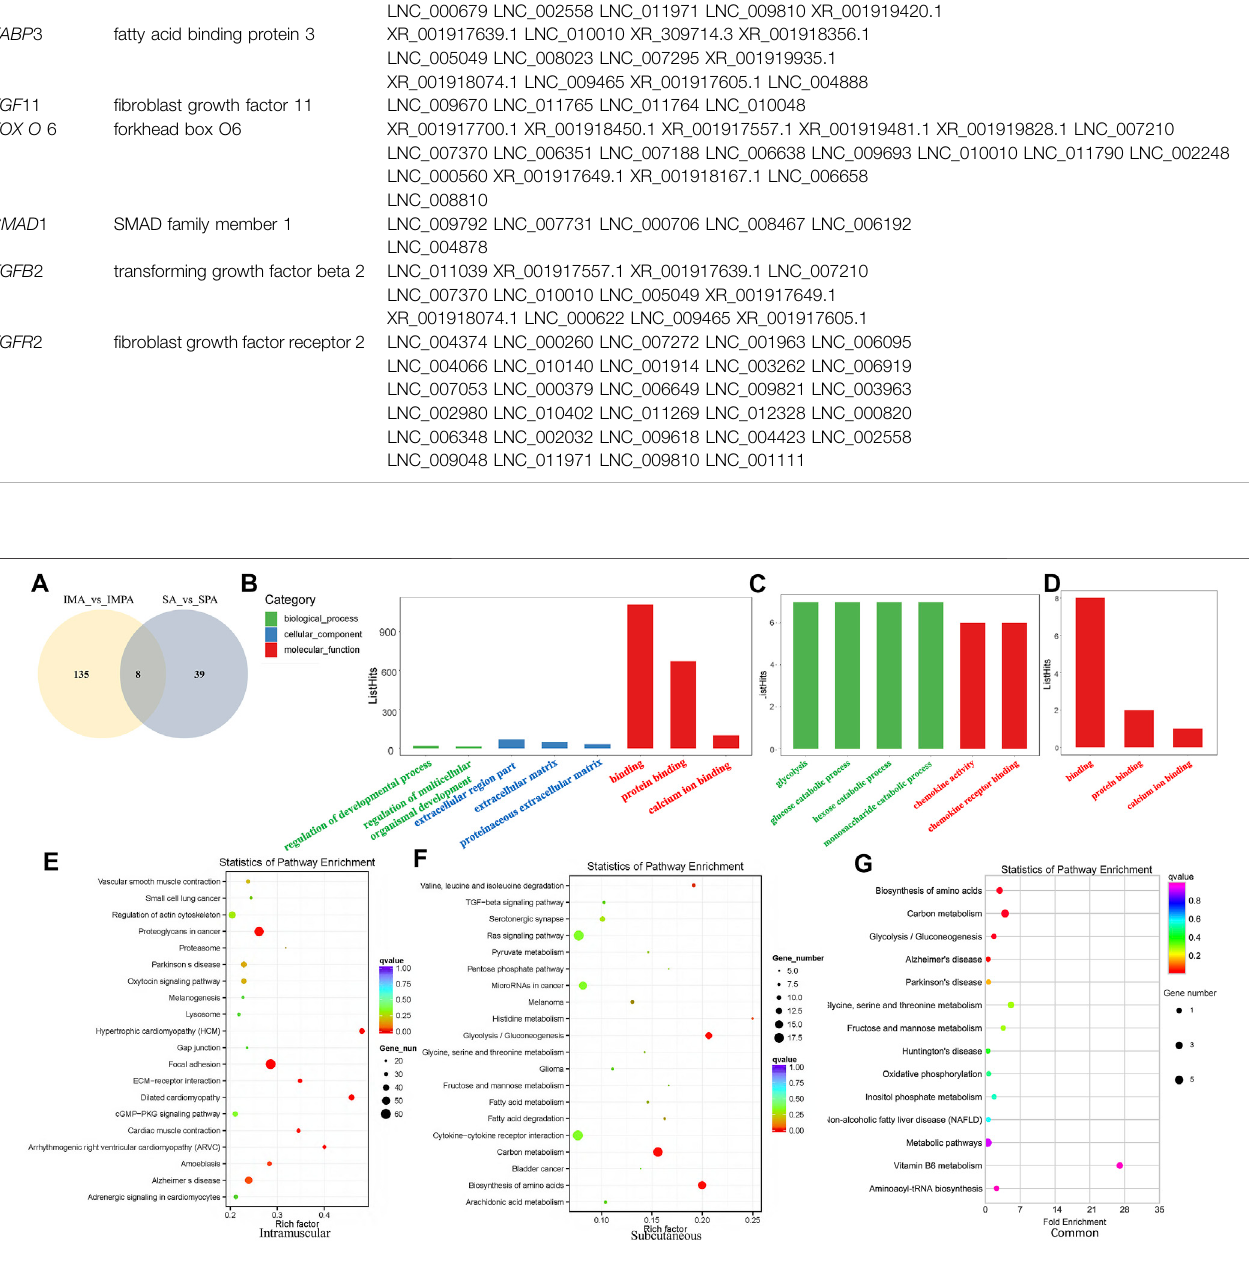
Frontiers in Physiology |